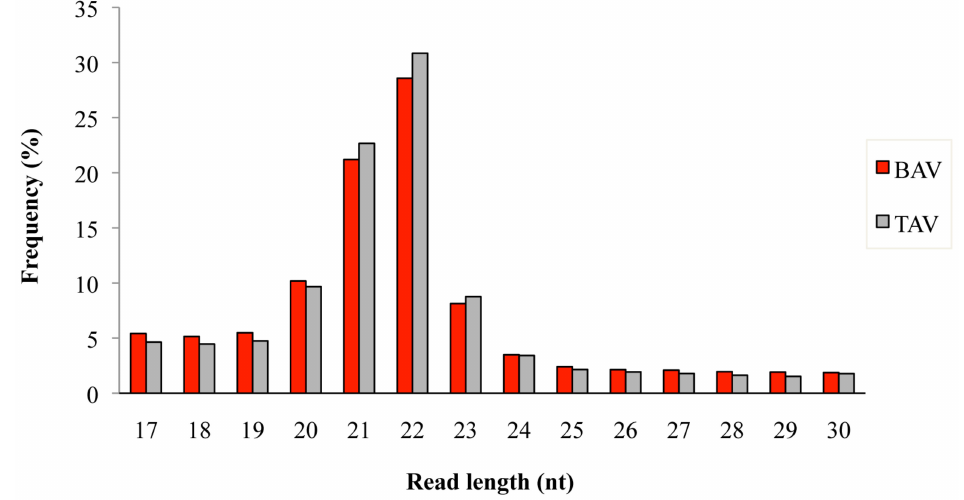
Figure 1. Length distribution of mapped sequence reads in bicuspid aortic valve (BAV) and tricuspid aortic valve (TAV)